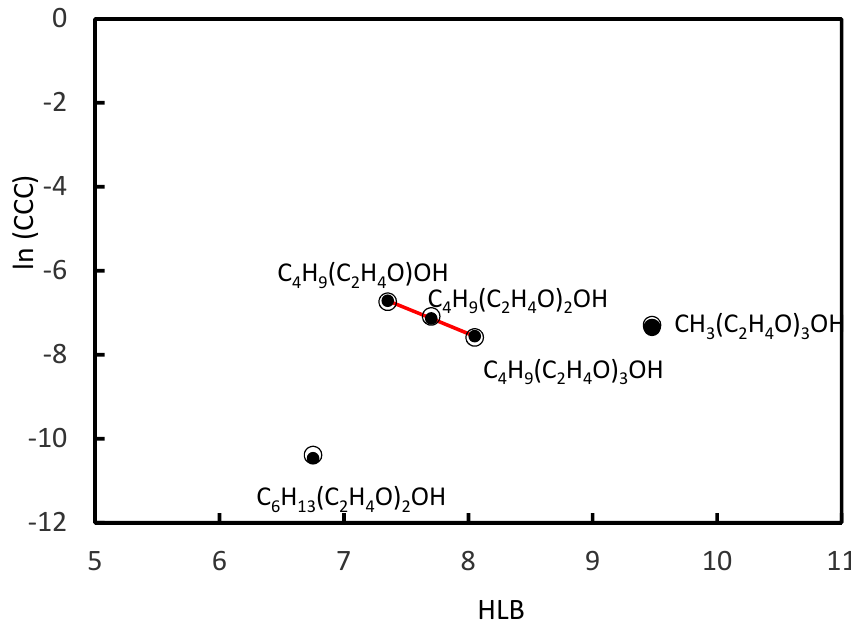
Figure 7. ln(CCC) versus HLB of Ethoxy frothers–full circles–experimental values, empty circles represent the theoretical values; empty dots represent the experimental values, while the full dots correspond to the theoretical values.